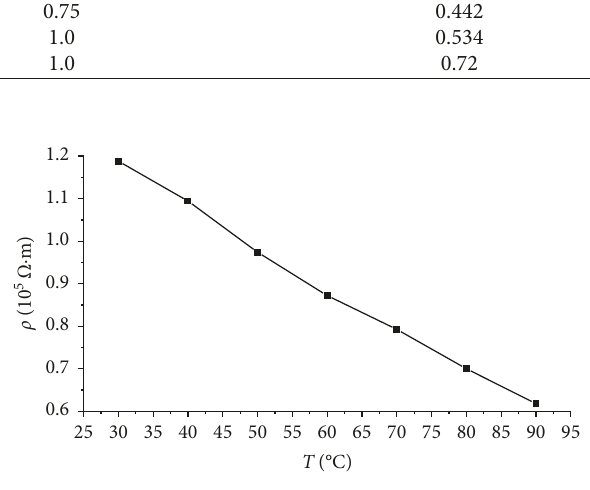
Figure 2: Resistivity of coal vs.